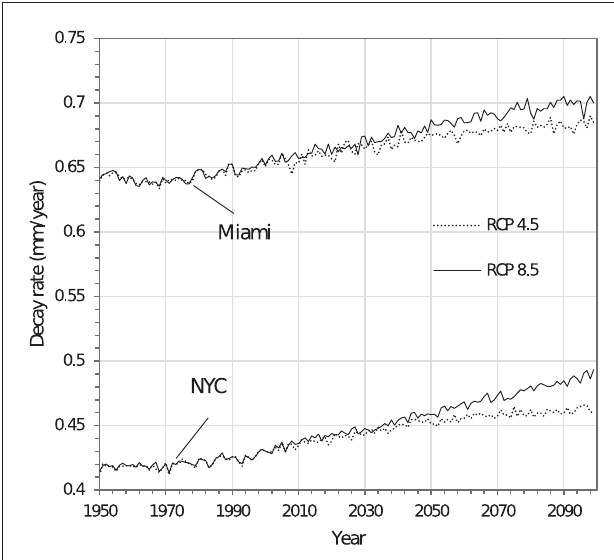
FIGURE 3 | Impact of climate change on the decay rate (based on medians).